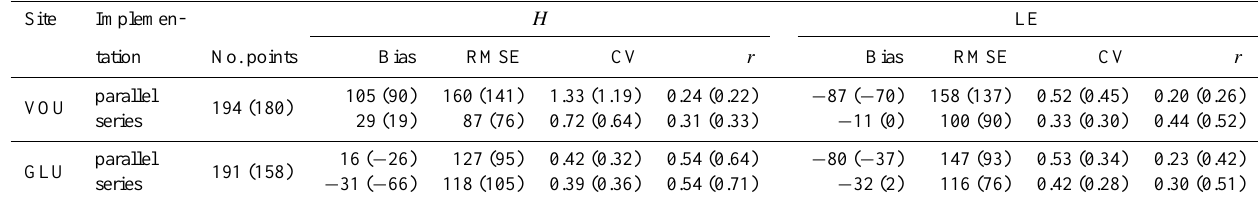
Table 1. Statistical comparison of modelled vs. observed sensible and latent heat fluxes at VOU and GLU for the “parallel” and “series” implementation of DTD. Modelled fluxes are instantaneous at the time of daytime Terra/Aqua overpass and observed fluxes are 30min averaged EC measurements. Numbers in parentheses indicate statistics only for model runs when “parallel” DTD converged to a plausible solution (LE > 0Wm − 2 ) while numbers outside brackets present statistics for all model runs, even when a backup formulation was used. The statistical parameters used are bias (modelled–measured), root mean square error (RMSE), coefficient of variation (CV – RMSE divided by mean of observed values), and correlation ( r ). Bias and RMSE are in Wm − 2 , the other parameters are